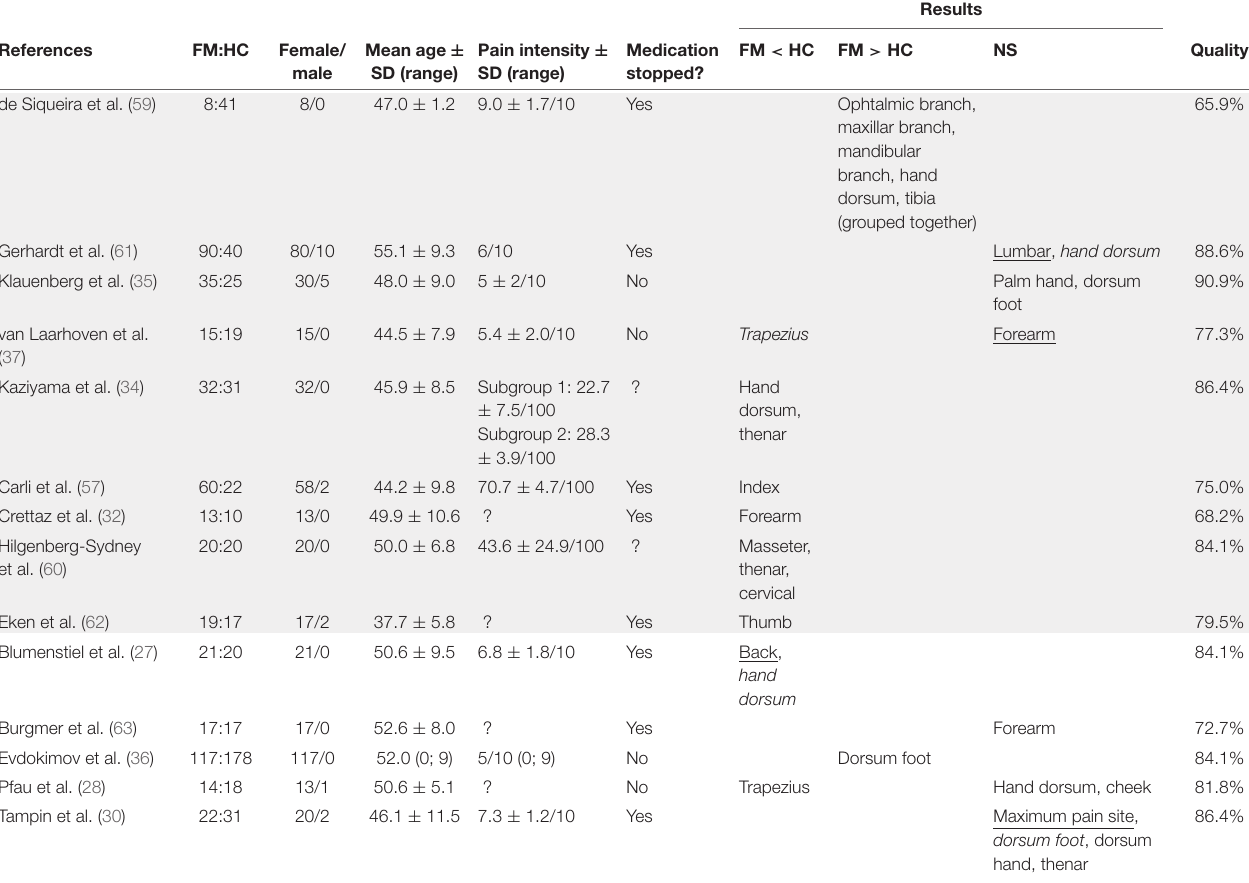
TABLE 2 | Studies included in the review with measures of